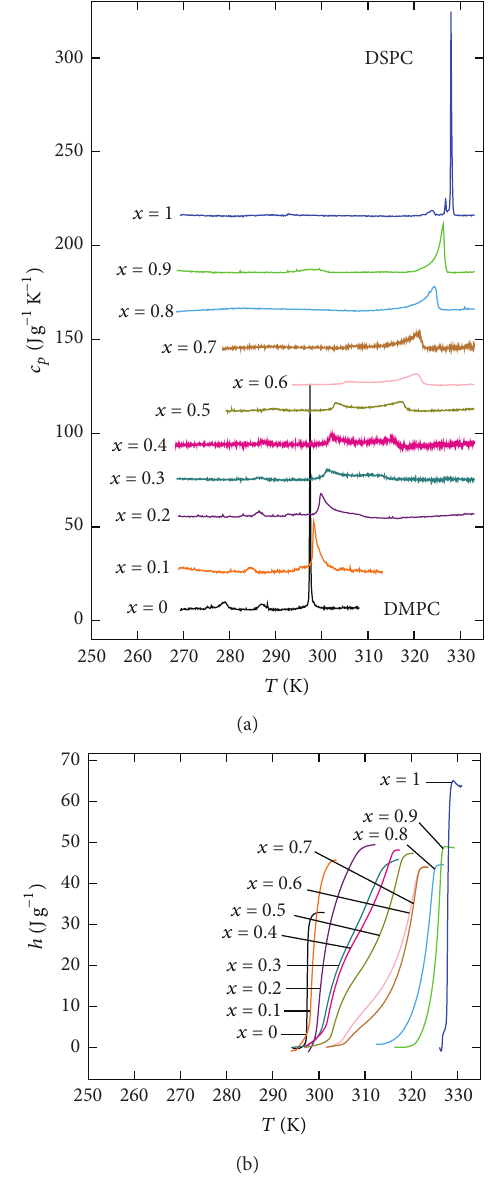
Figure 5: (a) Specific heat capacity 𝑐 𝑝 (𝑇) of the lipids in 10 mgmL −1 dispersions of DMPC + DPPC mixtures over the complete concen- tration interval. (b) ℎ(𝑇) discontinuities at the main phase transition temperature for the mixtures displayed. The 𝑐 𝑝 values have been shifted for better display; 𝑥 refers to the mole fraction of DPPC in the lipid mixture.